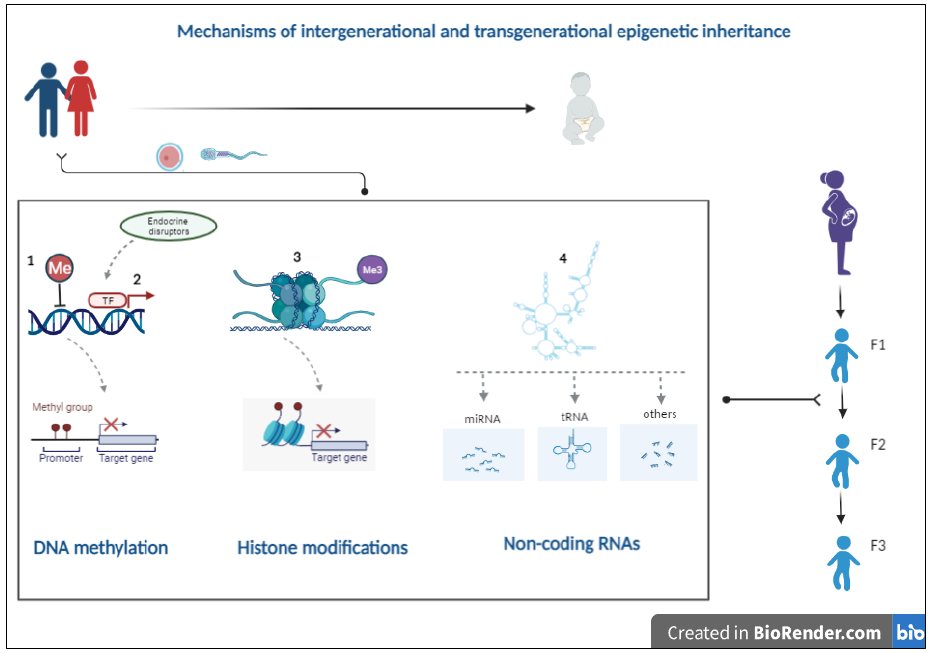
Figure 1. Parental pre-conception and in utero exposure to chemical substances, such as pesticides, cause epigenetic alterations in the germline that can be transmitted between generations and affect disease (including cancer) susceptibility in the progeny. Several mechanisms play a potential role in intergenerational and transgenerational transmission of disease predisposition including DNA methy- lation (1), transcription factor-associated DNA methylation patterns (2), histone modifications (3) and non-coding RNAs (4). Details are described in Section